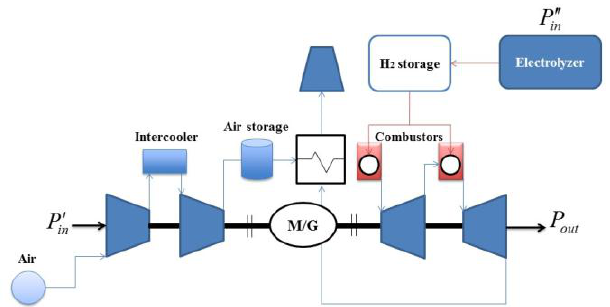
Figure 6. Hybrid storage system with regeneration, intercooled compression, and reheated expansion.